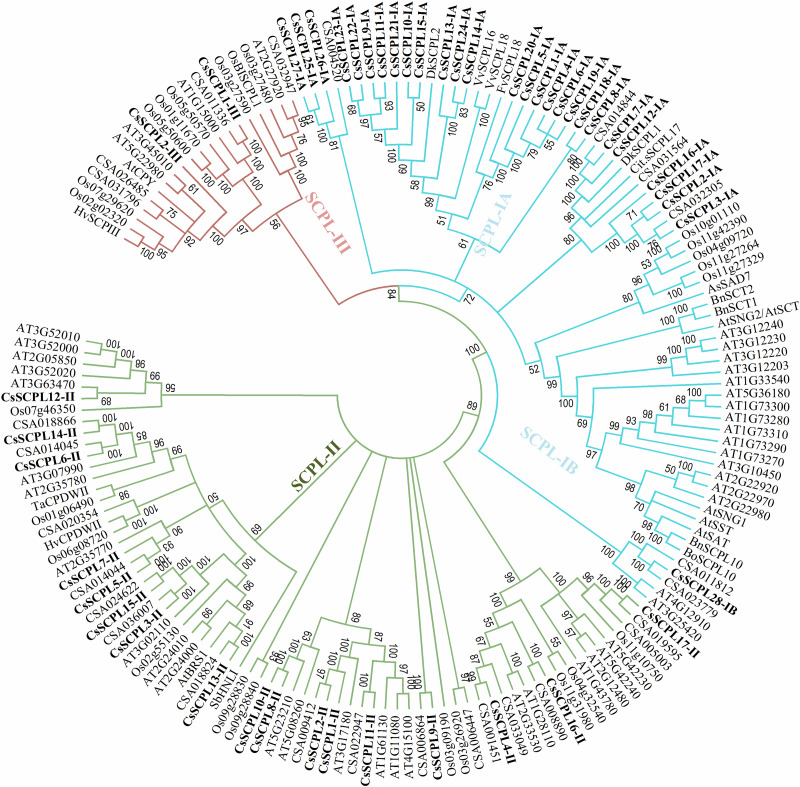
Phylogenetic tree of tea SCPL family genes with characterized SCPL genes from different plant species. The tree was constructed with MEGA 6.0 using the Neighbor-Joining (NJ) method. Bootstrap values in percentage (1,000 replicates) are indicated on the nodes. The subclades are identified with different colors: SCPL-I (blue), SCPL-II (green), and SCPL-III (maroon).